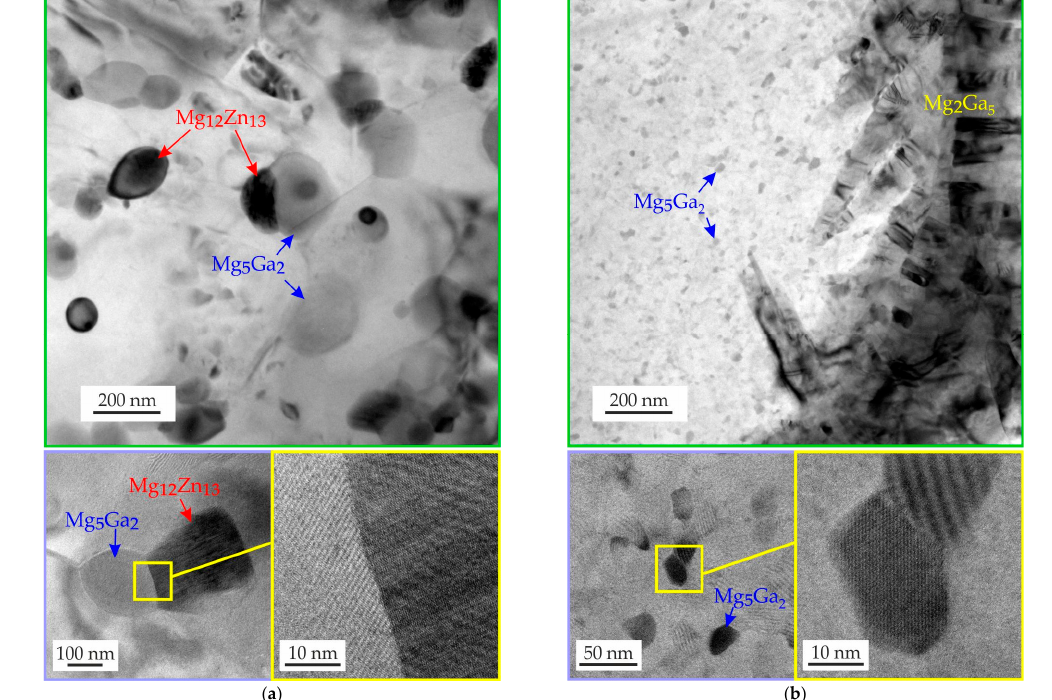
Figure 7. TEM images of ( a ) MgZn4Ga4 alloy extruded at 200 °C and ( b ) MgZn2Ga2 alloy extruded at 150 °C. In the MgZn2Ga2 alloy extruded at 150 °C, only Mg–Ga precipitates were found, but their compositions and sizes were different (Figure 7b). Most of the precipitates had a size of 20–50 nm and their composition was close to that of Mg 5 Ga 2 . However, large precipitates (up to 1 μ m) and compositions close to Mg 2 Ga 5 or MgGa were also observed, but their volume fraction was low. The Mg 5 Ga 2 precipitates also formed agglomerates. Thus, the large fraction of small precipitates must provide high mechanical properties. The insets in Figure 3 in the blue box show the microstructure of the alloys after etching. The grain structure was close to a fine DRX one, but a small fraction of coarse non-DRX grains was also observed. The average grain sizes of the Mg–Zn–Ga–(Y) alloys extruded at different temperatures are shown in Figure 8. The grain sizes of the MgZn4Ga4 alloys formed at extrusion temperatures of 150 or 200 °C were not measured because the samples could not be effectively etched due to high fraction of intermetallic phases in its structure. However, it can be concluded that the finer grains were observed at lower extrusion temperatures, and for the MgZn2Ga2 alloy, it is more clearly seen.